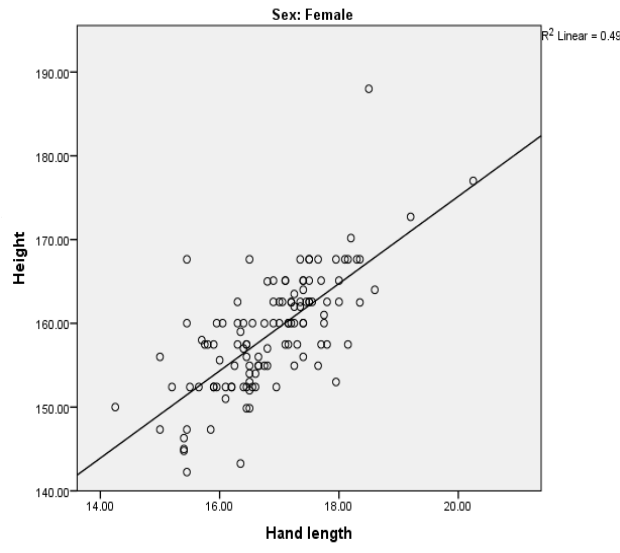
Fig 1: Relationship between height and hand length in females